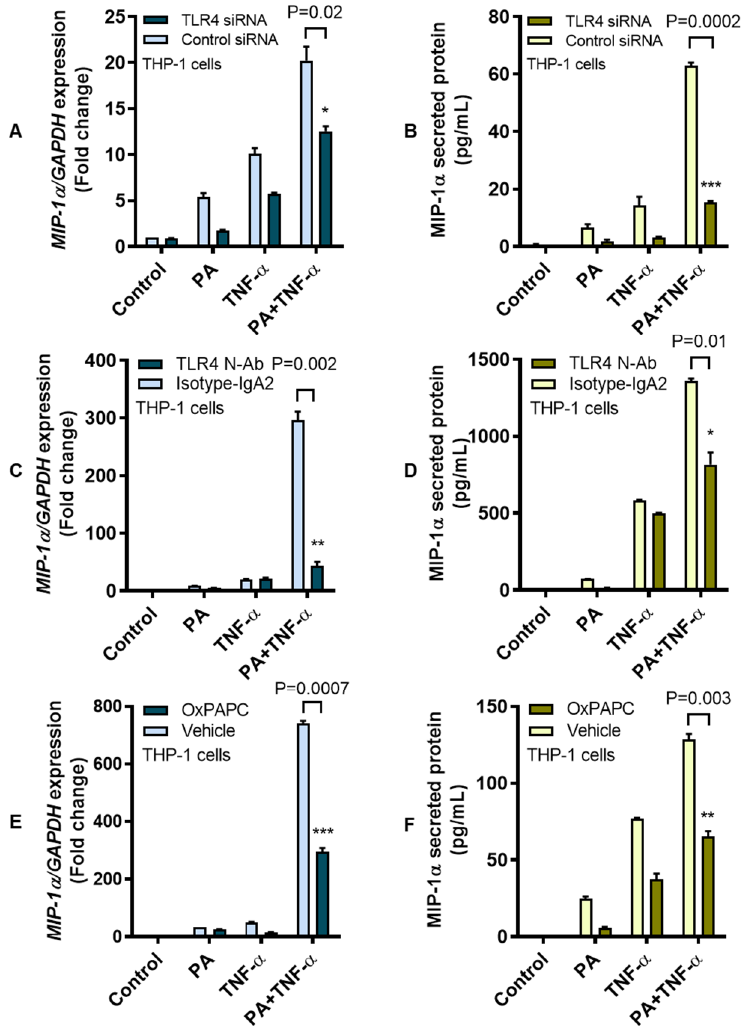
Figure 2. MIP-1 α co-induction by palmitate and TNF- α implicates the TLR4-mediated signaling. TLR4 signaling activity in THP-1 cells was intercepted by multiple approaches such as genetic ablation with TLR4-specific siRNA, receptor blocking with TLR4 neutralizing antibody, and chemical inhibition with TLR4 inhibitor OxPAPC as described in the Materials and Methods section. The representative data (mean ± SEM) from three independent determinations with similar results show that co-induction of MIP-1 α by palmitate and TNF- α was suppressed at the levels of ( A ) MIP-1 α transcripts ( P = 0.02) and ( B ) MIP-1 α secreted protein ( P = 0.0002) in THP-1 monocytic cells transfected with TLR4 siRNA as compared to controls transfected with scrambled siRNA. Similarly, MIP-1 α expression co-induced by palmitate and TNF- α was reduced at the levels of ( C ) MIP-1 α mRNA ( P = 0.002) and ( D ) MIP-1 α secreted protein ( P = 0.01) in THP-1 cells that were treated with anti-TLR4 neutralizing antibody compared to controls treated with isotype-matched IgA2 antibody. In line with these results, treatment of THP-1 monocytic cells with OxPAPC inhibitor also reduced the expression of ( E ) MIP-1 α transcripts ( P = 0.0007) and ( F ) MIP-1 α secreted protein ( P = 0.003) compared to controls treated with the vehicle only before co-stimulation with palmitate and TNF- α . * P < 0.05, ** P < 0.01, *** P < 0.001.